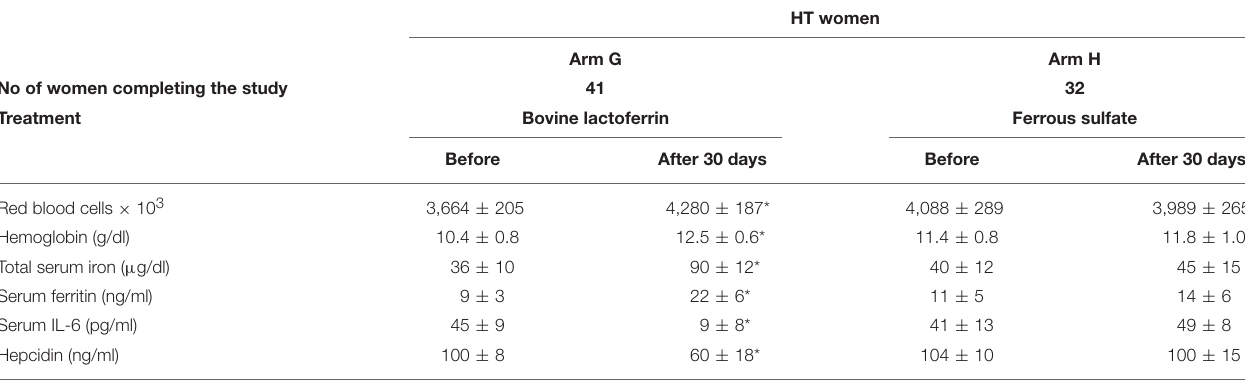
TABLE 10 | Hematological parameters, serum IL-6 and hepcidin mean values ± SD of HT women of child-bearing age, suffering from AI treated with bovine lactoferrin (Arm G) or with ferrous sulfate (Arm H), before and after 30 days of